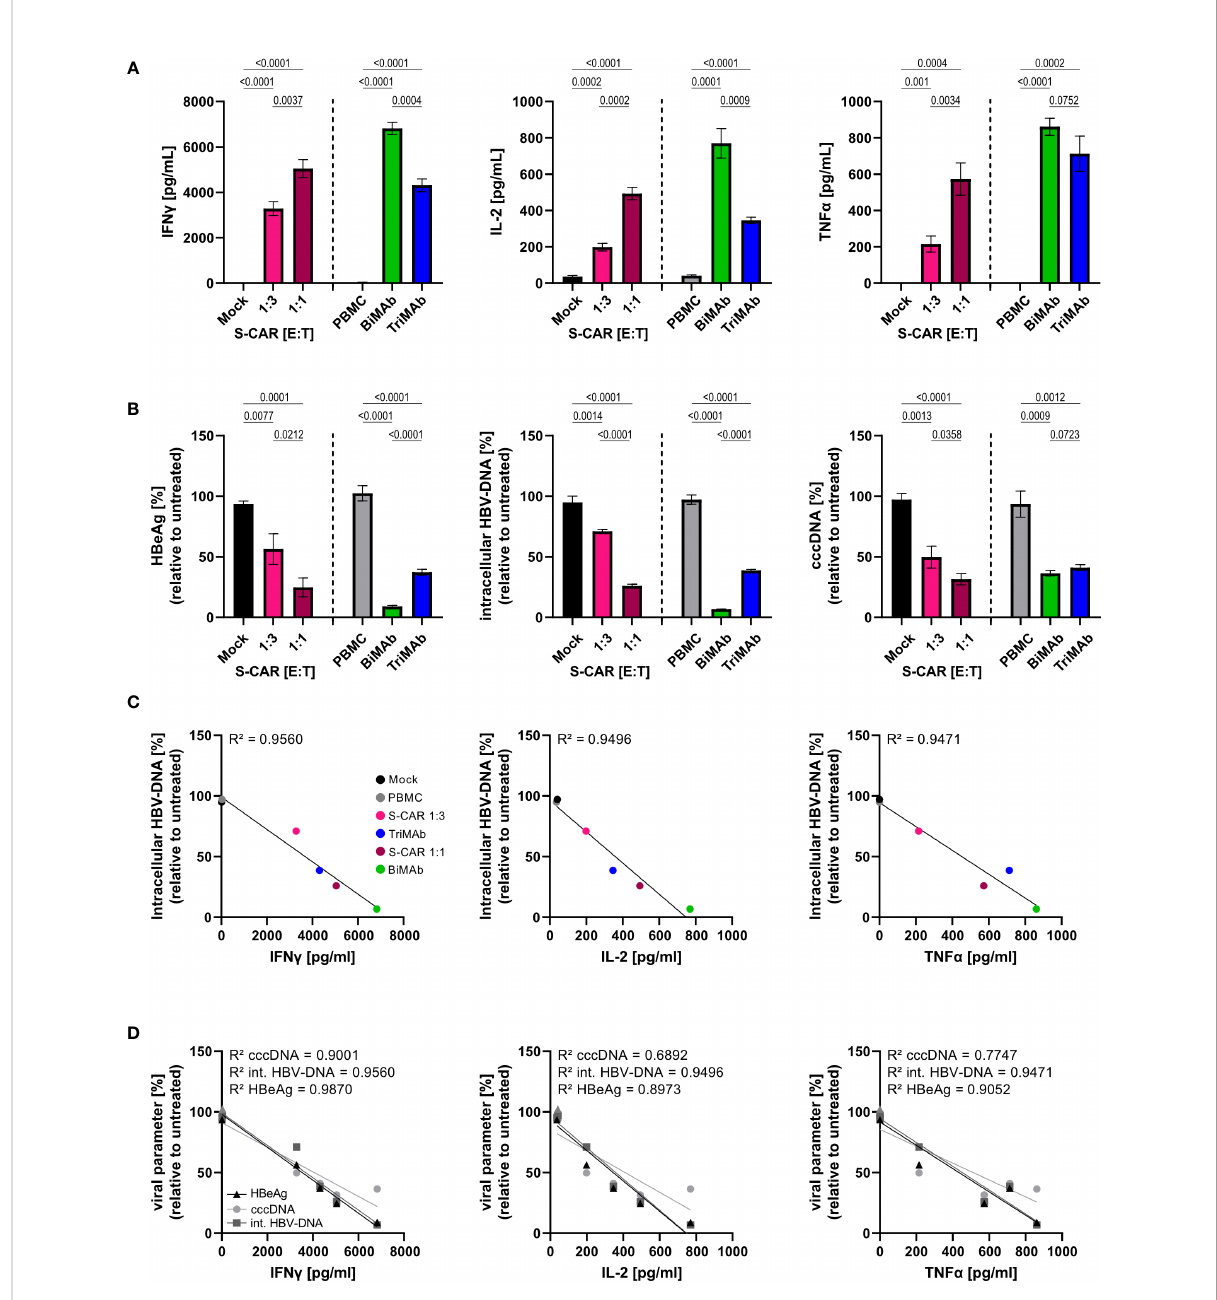
FIGURE 4 Non-cytolytic antiviral effect of S-CAR T cells and PBMC activated by T-cell engager antibodies. HepaRG cells were differentiated and infected with HBV at an MOI of 200 virions/cell. Huh7S cells and effector cells were cultured in a transwell inserted into wells containing HBV-infected HepaRG cells to avoid direct contact. In the inlet, S-CAR-grafted T cells at indicated E:T ratios or PBMC in combination with 10 nM BiMAb a CD3 and BiMAb a CD28 in a 1:1 ratio, or 10 nM TriMAb were co-cultured with HBVenv-expressing Huh7S cells for 7 days. Mock-transduced T cells or PBMC in the absence of engager antibodies served as controls. The number of PBMC was adjusted to an E:T ratio of 1:1, expecting PBMC to contain 60% T cells. (A) Levels of IFN g (left), IL-2, (middle) TNF a (right) and in the supernatant were quanti fi ed by ELISA. (B) HBeAg in the supernatant (left), or intracellular HBV-DNA (middle) and cccDNA (right) in cell lysates were quanti fi ed by HBeAg BEP III test or qPCR, respectively. (C) The coef fi cient of determination (R 2 ) between the levels of intracellular HBV-DNA in lysates and the concentration of IFN g (left), IL-2 (middle), and TNF a (right) in the supernatant was calculated using the Pearson correlation. (D) The coef fi cient of determination (R 2 ) between the levels of the viral parameters HBeAg, intracellular HBV-DNA, or cccDNA, and the concentration of IFN g (left), IL-2 (middle), and TNF a (right) in the supernatant was calculated using the Pearson correlation. Trend lines were calculated by simple linear regression. Data are presented as mean values ± SD of triplicates (n = 3). To calculate p-values, we used 2-tailed unpaired